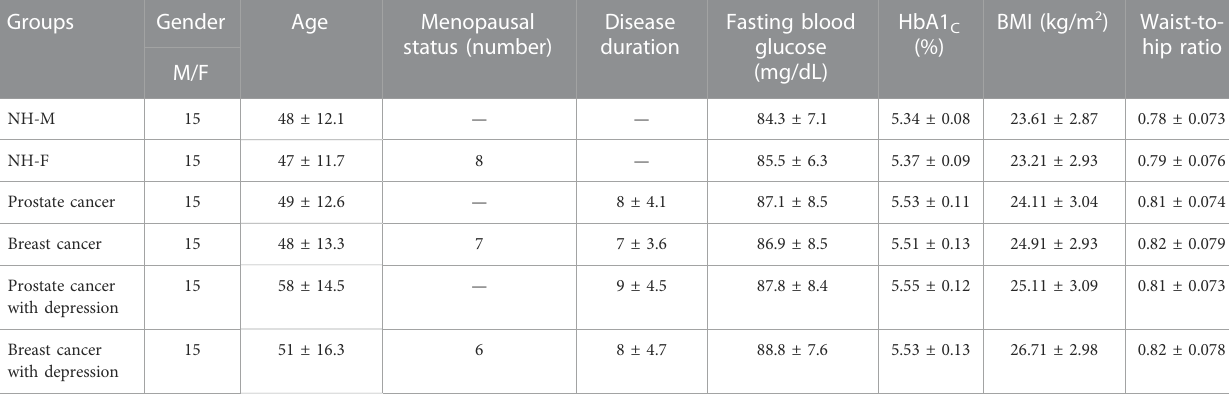
TABLE 1 Clinical and demographic presentation of cancer and healthy subjects.